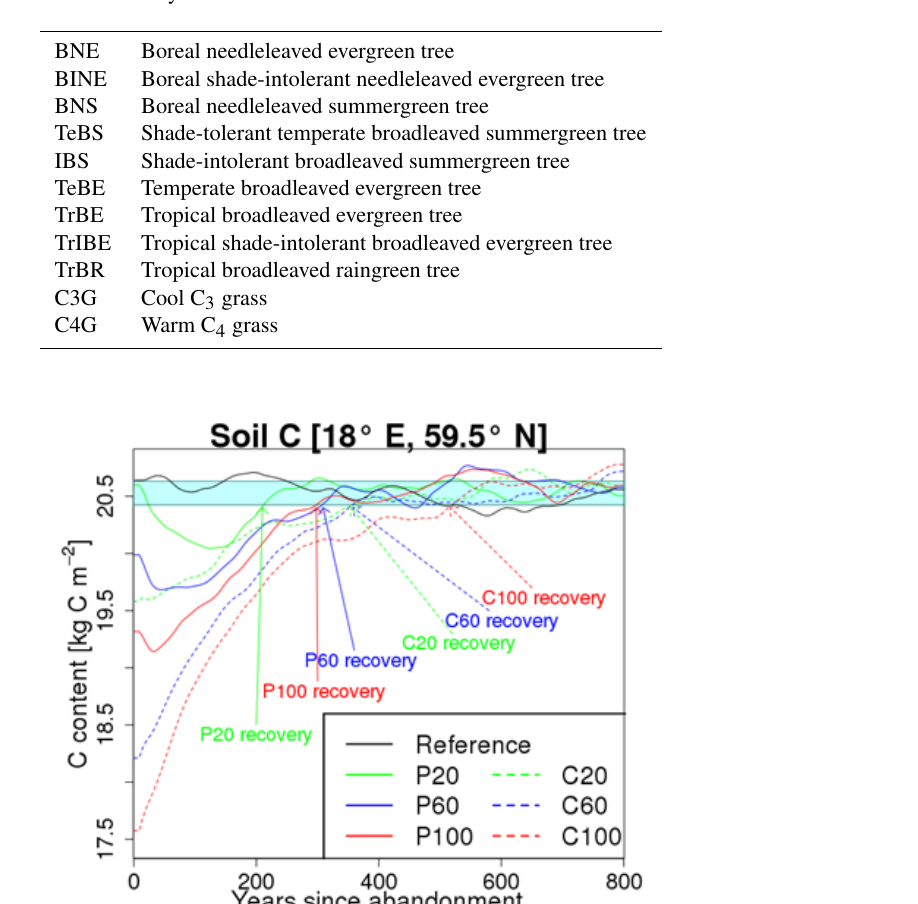
Table A1. Plant functional types used in this study.